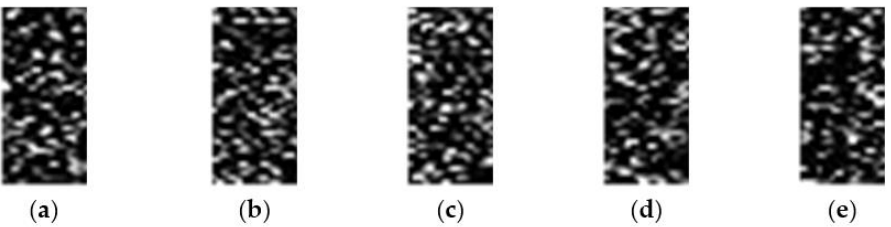
Figure 14. Partial 20 × 40 sample graph without target under the condition of 0 dB SNR, and the units are ( a ) 1000th, ( b ) 2000th, ( c ) 3000th, ( d ) 4500th, and ( e ) 6000th. For 40 × 20 image blocks (40 is the number of distance units, 20 is the number of echo cycles): move the echo range unit by 5, 8, 11, 15, 18, 23, 25, 28, 31, 34, and 37, the blocks are divided by 40, and the targets are all on the 2500th range block unit, but at different positions of the unit: 0.9, 0.825, 0.75, 0.65, 0.575, 0.45, 0.4, 0.325, 0.25, 0.175, and 0.1, respectively. Figure 15 is a graph of target samples at different positions when the SNR is 0 dB; the non-target samples are taken from the 400th, 800th, 1200th, 1600th, 2000th, 2400th, 2800th, 3200th, 3600th, 4000th, and 4400th range block units, Figure 16 is a graph of non-target samples at different positions when the signal-to-noise ratio is 0 dB. Figure 15. Partial 40 × 20 sample graph with target under the condition of 0 dB SNR, and the target in unit positions are ( a ) 0.9, ( b ) 0.825, ( c ) 0.75, ( d ) 0.65, ( e ) 0.575, ( f ) 0.45, ( g ) 0.4, ( h ) 0.325, ( i ) 0.25, ( j ) 0.175, and ( k ) 0.1.